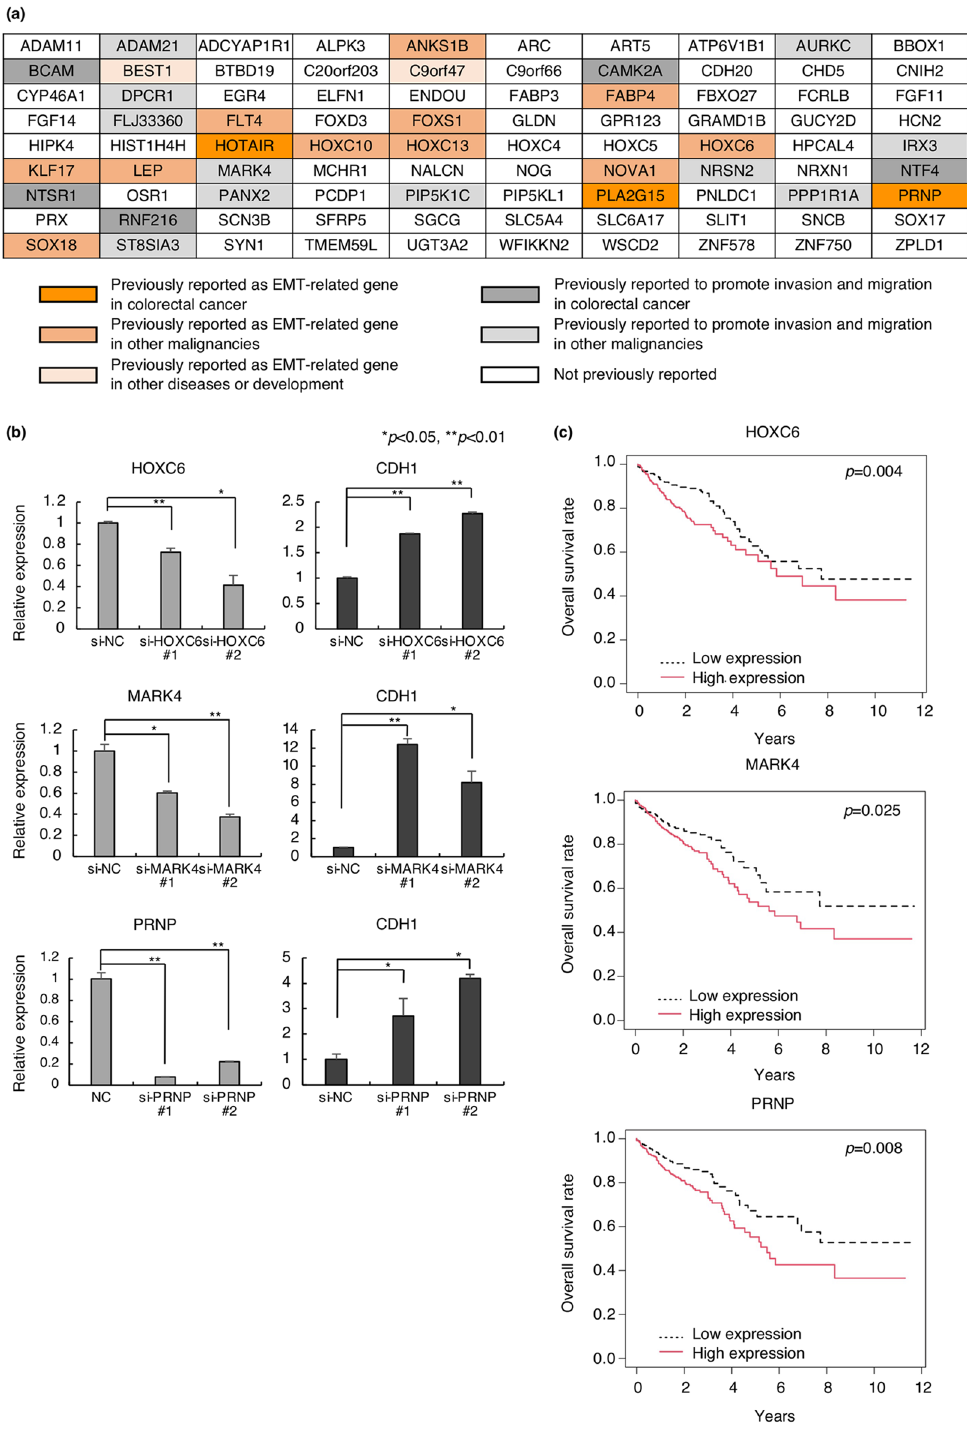
Figure 2. Association between candidate genes and EMT. ( a ) Previous reports of 90 candidate genes of EMT, cell invasion, or migration. Genes previously reported as EMT-related genes in CRC are shown in red, genes in other malignancies are in orange, and genes in other disease and development are in light orange. Genes previously reported to promote invasion and migration in CRC are shown in dark gray, genes in other malignancies are in light gray, and genes with no previous reports associated with either EMT, invasion, or migration are in white. ( b ) Alteration of CDH1 expression by knockdown of three candidate genes, HOXC6, MARK4, and PRNP in HCT116. All experiments were conducted in triplicate. Error bars show standard errors of the mean. Asterisks denote significant differences using unpaired 2-tail t-test (* p < 0.05, ** p < 0.01). ( c ) Kaplan–Meier curves for overall survival in patients with CRC according to expression of HOXC6, MARK4, and PRNP ( p = 0.004, 0.025, and 0.008, respectively). Patients are divided into two groups by the mean. These data were obtained from Broad GDAC Firehose colorectal adenocarcinoma (COADREAD) dataset (https:// gdac. broad insti tute. org/) (n = 615).